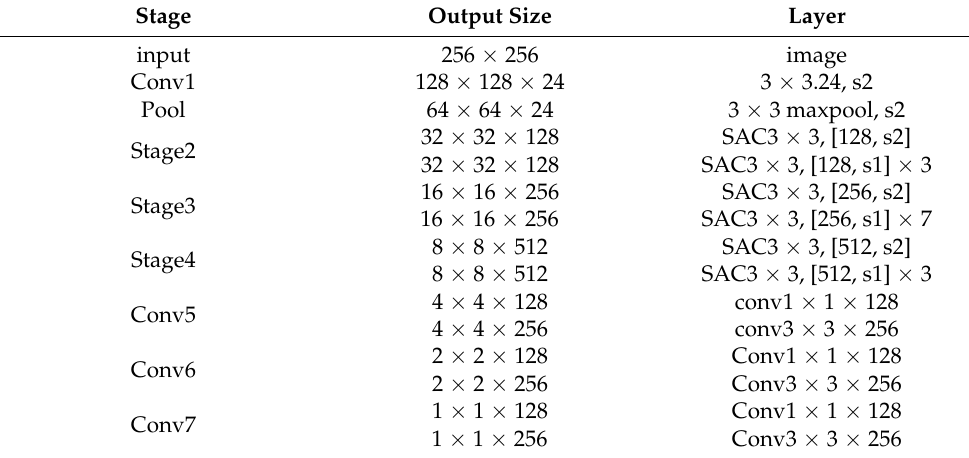
Table 1. The architecture of the MSF-SNET backbone networks. SNet was used as a basic framework but replaces all 5 × 5 depthwise convolutions with 3 × 3 separable atrous convolutions (dilated rate = 2). SAC in the table stands for separable atrous convolution. The number after close bracket means this module will be repeated the number times. For example, SAC3 × 3, [128, s1] × 3 in stage 2, 3 after close bracket means this module will be repeated 3 times.